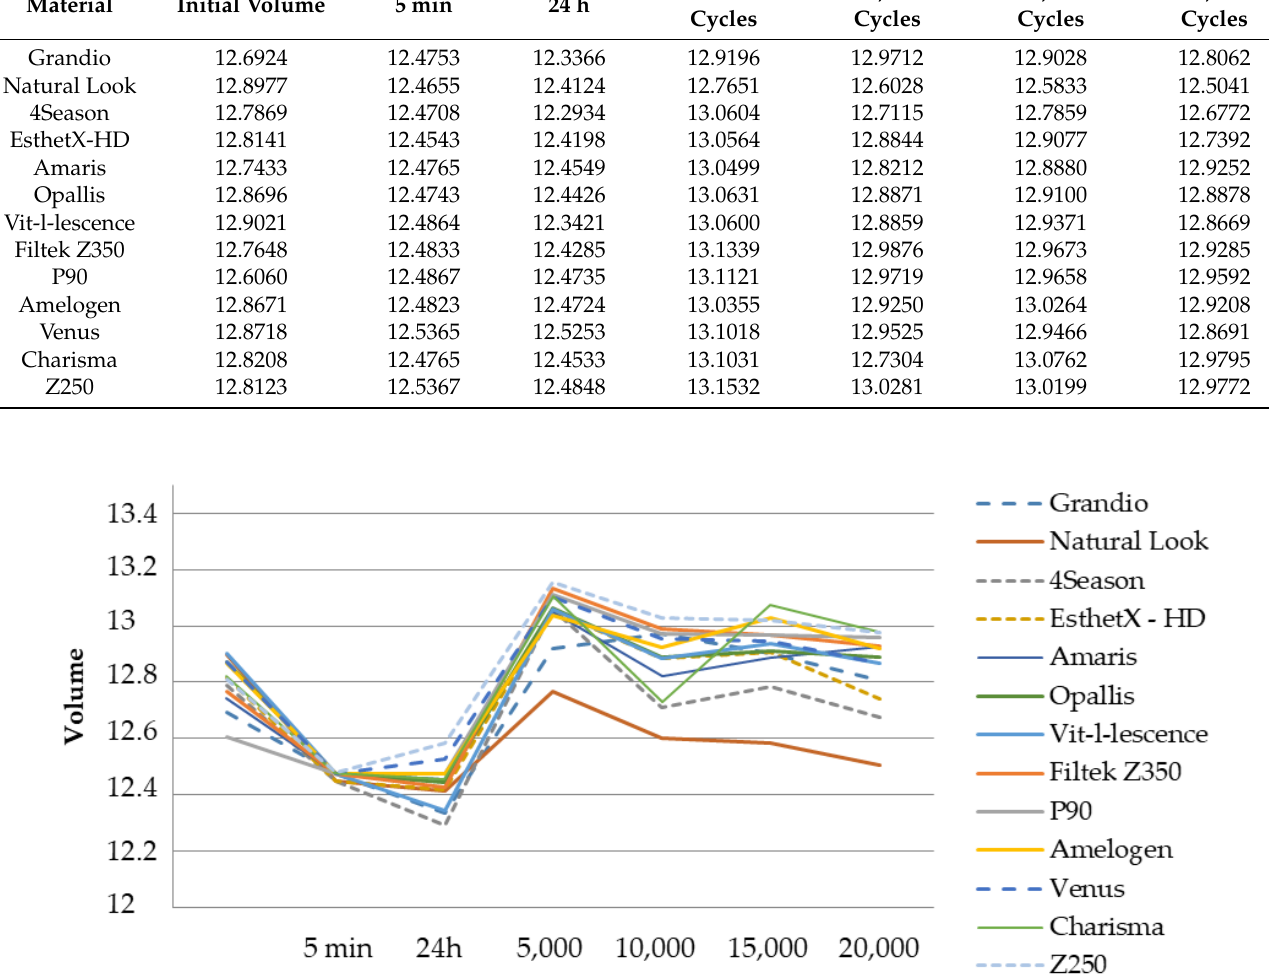
Figure 5. Resin composite hygroscopic expansion trend in function of the aging process progression (5 min, 24 h, 5000 to 20,000 thermal cycles.